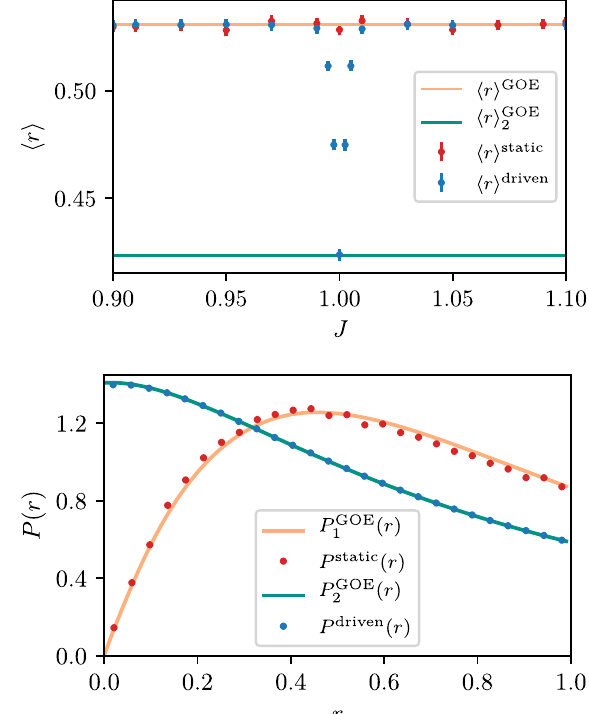
FIG. 7. Top panel: average gap ratio as a function of J in the time-independent and driven spin- 1 = 2 chain model, Eq. (65). Bottom panel: gap ratio distributions at J ¼ 1 for the time- independent and driven case (points), and comparison with the surmise distribution for m ¼ 1 and m ¼ 2 GOE blocks (solid lines). In the time-independent case, the average is performed over 2000 disorder realizations (except at the J ¼ 1 point where 5000 realizations are used), and 100 eigenstates around infinite- E = 2 , for the system of size temperature energy E ¼ ð E min þ max Þ L ¼ 14 , while in the driven case, the average is performed over 2000 disorder realizations and all eigenstates of the system of size L ¼ 12